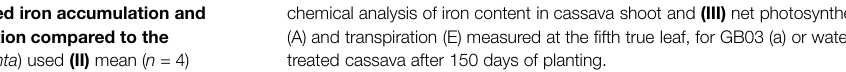
chemical analysis of iron content in cassava shoot and (III) net photosynthesis (A) and transpiration (E) measured at the fifth true leaf, for GB03 (a) or water (b) treated cassava after 150 days of